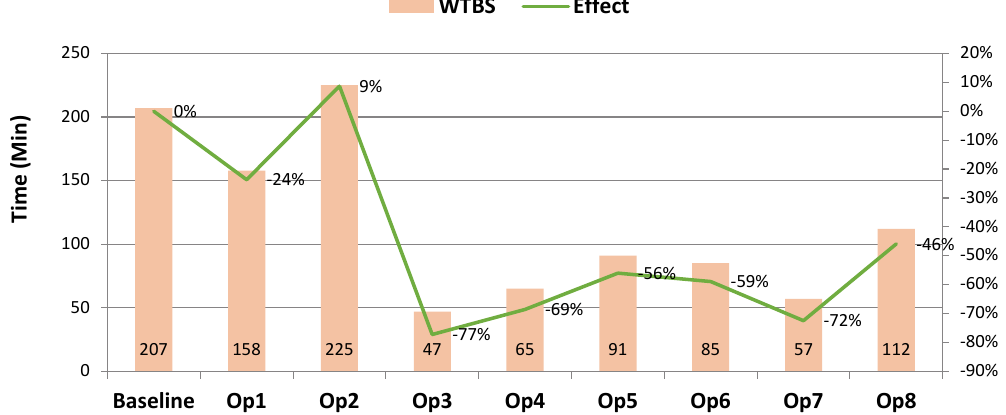
Fig. 9 . Results of patient average waiting time by using different PIT allocation options in comparison with the baseline measure (8hrs in busy time)